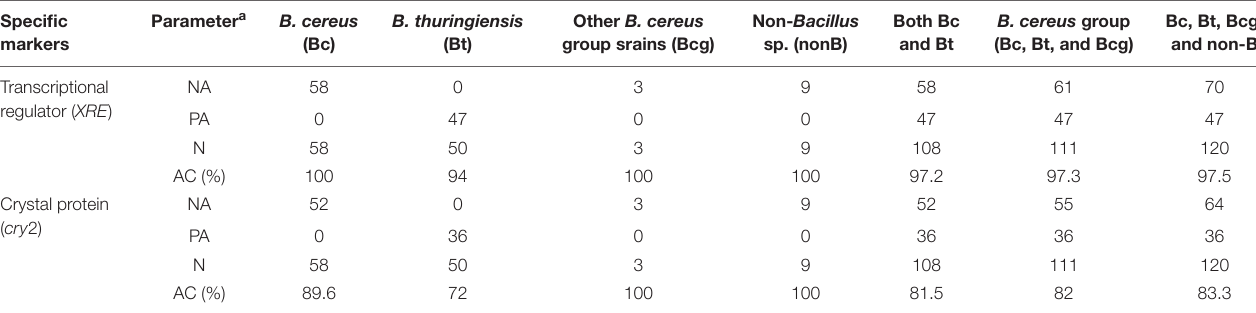
TABLE 2 | Detection of B. cereus group and non- Bacillus sp. targeting biomarkers of XRE and cry2 using PCR. Specific